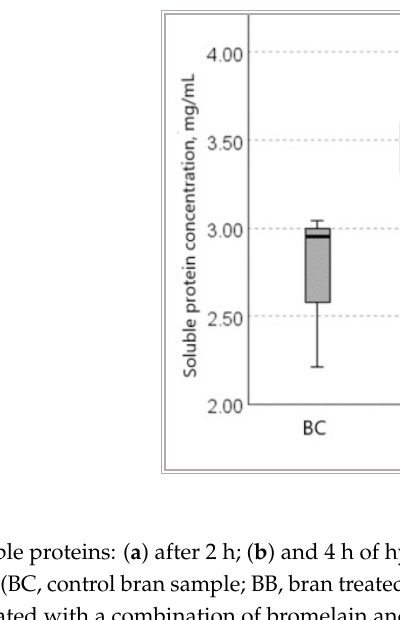
Figure 3. Changes in soluble proteins: ( a ) after 2 h; ( b ) and 4 h of hydrolysis with different enzymes for all bran samples tested (BC, control bran sample; BB, bran treated with bromelain; BP, bran treated with papain; BM, bran treated with a combination of bromelain and papain).